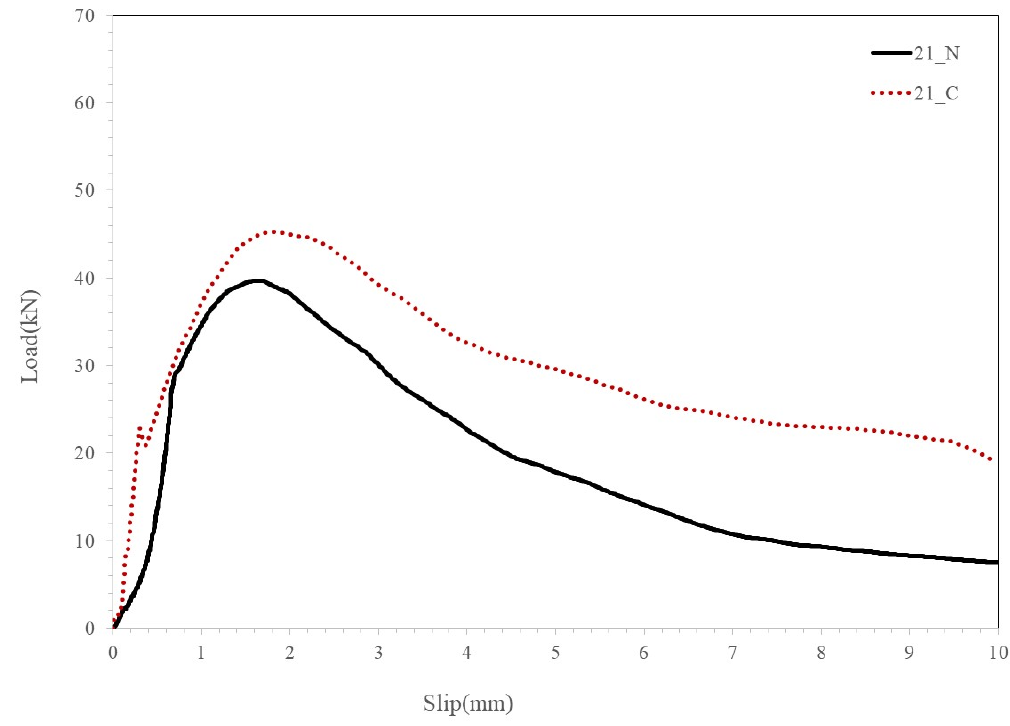
Figure 3. Load–slip curves with and without UHPC coating.